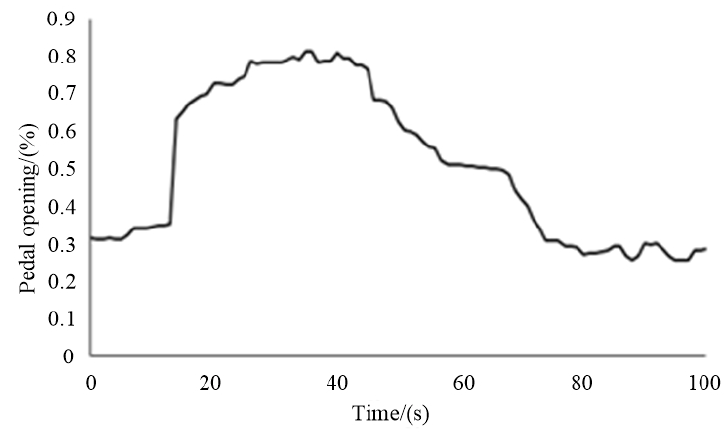
Figure 14. The pedal opening of the vehicle during the experiment.